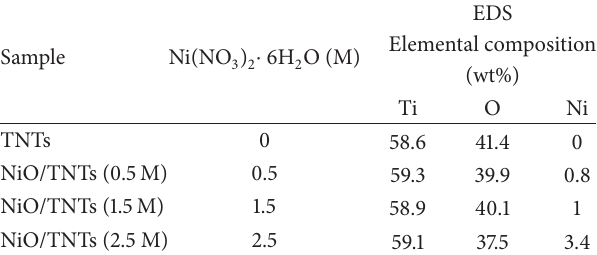
Table 1: Experimental conditions and elemental composition of the prepared composite samples.